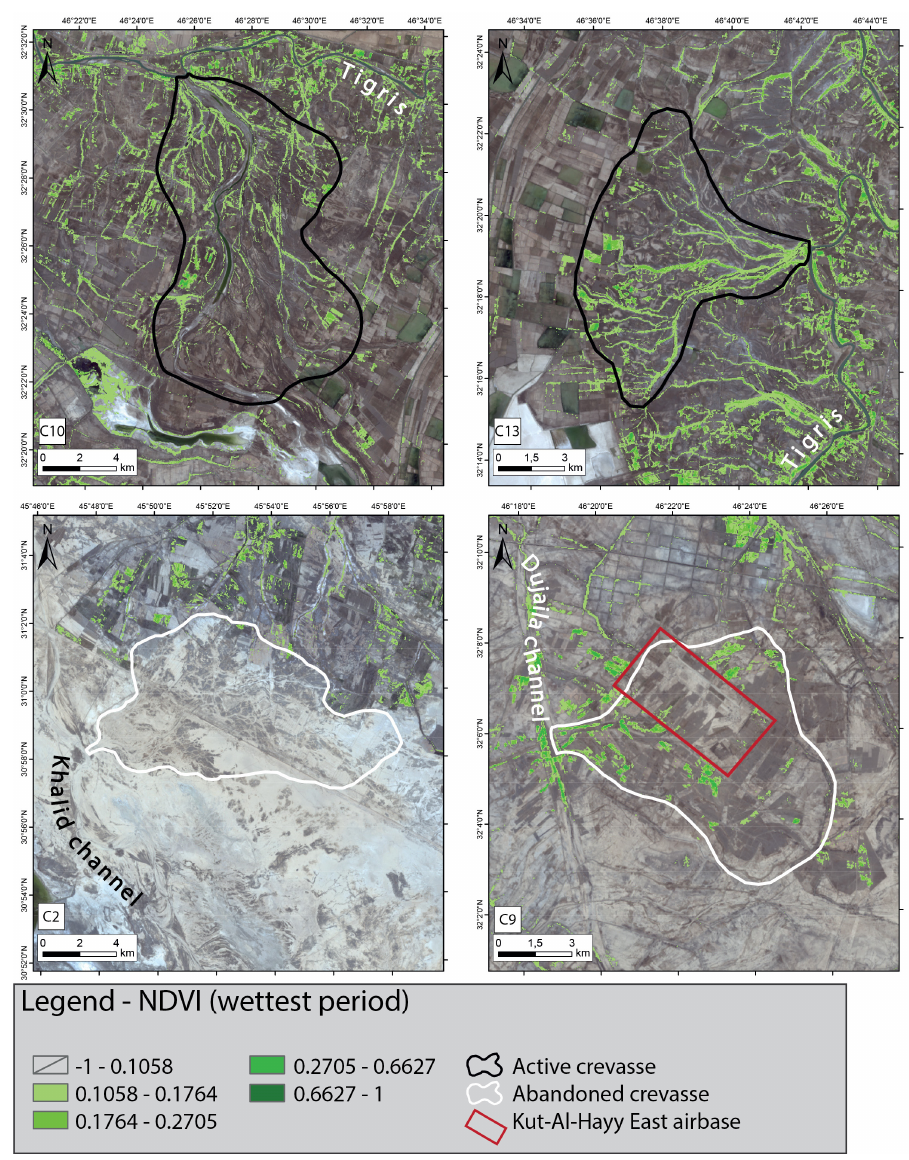
Figure 10. Spatial distribution of NDVI, during the wettest period, for the active ( C10 , C13 ) and the abandoned ( C2 , C9 ) crevasse splays.